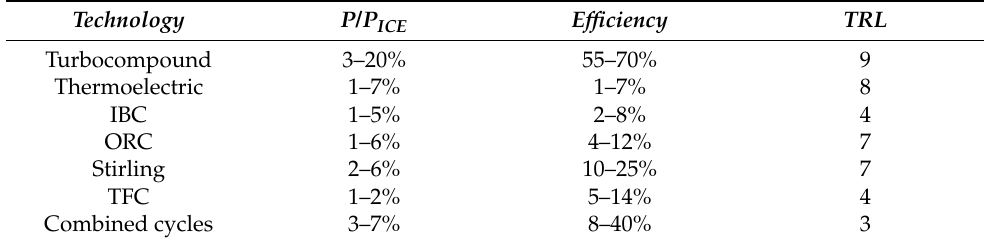
Table 3. Summary of the technologies reviewed.